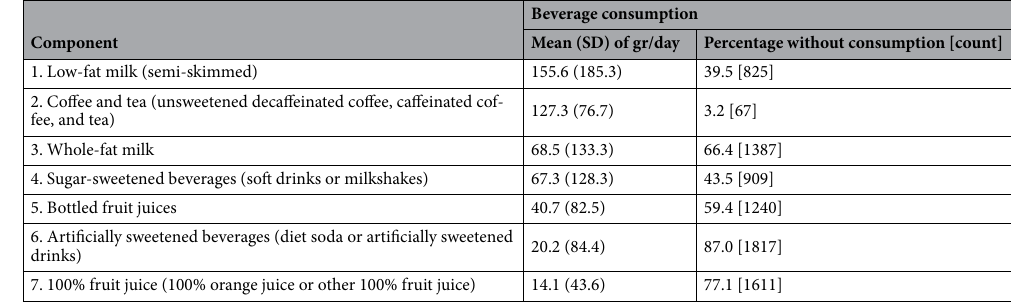
Table 1. Beverage consumption and the percentage of participants without consumption, among middle-aged men in the AWHS (N = 2089). Values are mean (standard deviation) or % [number]. Mean was computed including those without consumption.